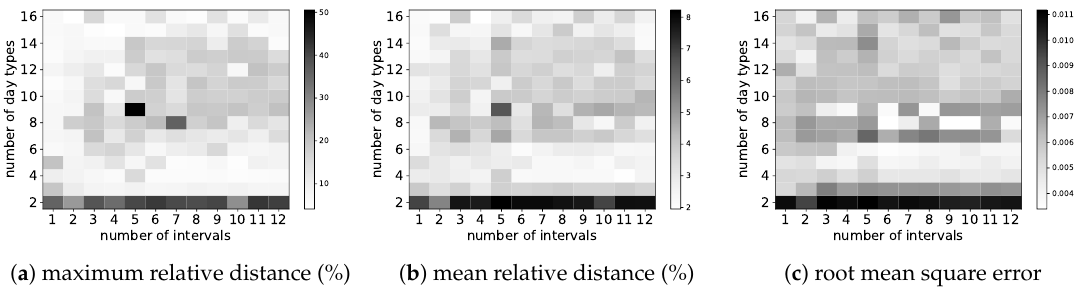
Figure 15. Performance of our forecast-based energy source model for